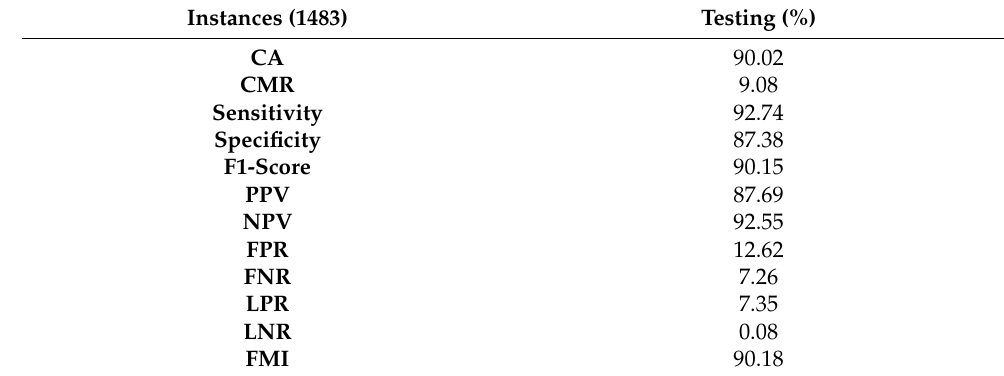
Table 6. Proposed model performance parameter results using transfer learning.